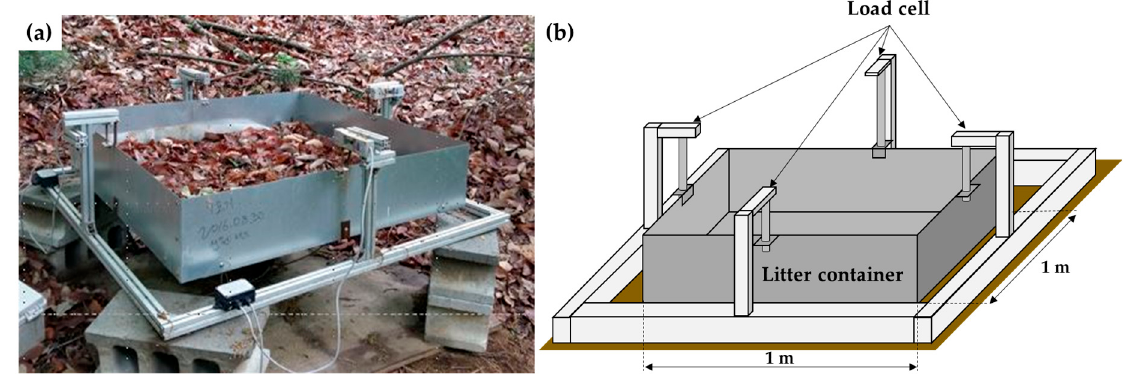
Figure 2. Litter lysimeter ( a ) and schematic diagram of the lysimeter ( b ). Table 1. Tree and leaf litter